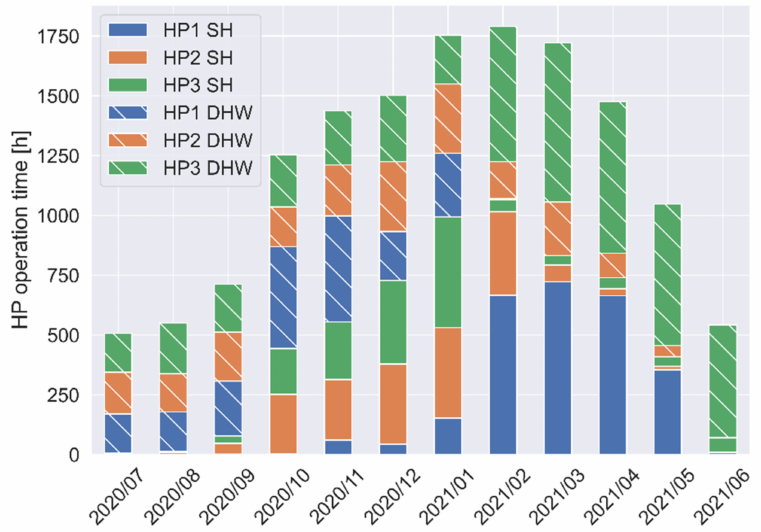
Figure 18. Heat pumps: operation time in space heating (SH) and domestic hot water (DHW) mode.